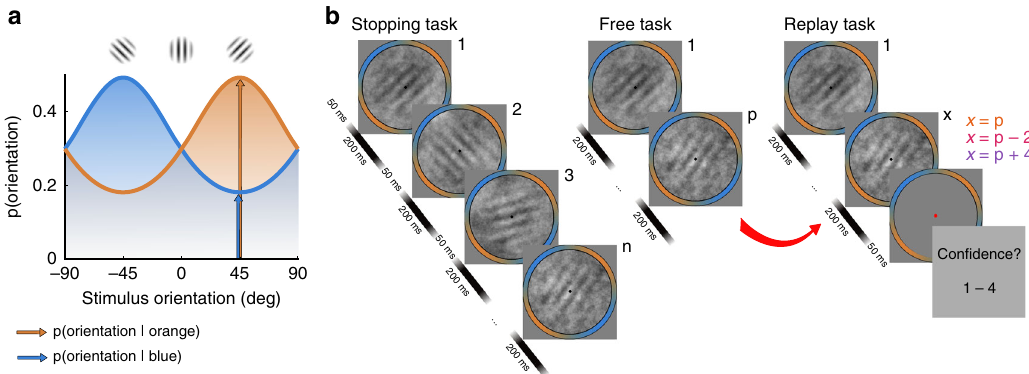
Fig. 1 Procedure. On each trial, observers were shown a series of oriented Gabors and had to determine which distribution the orientations were drawn from. a The orientations were drawn from one of two circular Gaussian (von-Mises) distributions centred on − 45° (blue) and + 45° (orange) relative to vertical (0°). The distributions were overlapping such that a stimulus oriented 45° from vertical is most likely to have been drawn from the orange distribution (orange arrow) but still could have been drawn from the blue distribution (blue arrow). b The experiment involved two sessions. In session 1, observers completed the Stopping task. On each trial of the Stopping task the series of stimuli continued until observers entered a Type-I response: blue or orange distribution. They were asked to enter their response when they felt they had a certain probability of being correct. The three target performance levels (70%, 85% and 90% correct) were completed in separate blocks. In session 2, observers completed the Free task followed by the Replay task. The Free task was the same as the Stopping task, except observers were asked to enter their response when they felt ready (after p samples). In the Replay task, observers entered their Type-I response once cued ( fi xation changing to red). They then gave a Type-II response: a rating (1 to 4) of how con fi dent they were that they were correct. Unbeknownst to observers, the Replay task actually replayed the exact same trials from the Free task, except the number of samples was either the same as they had chosen to respond to ( x = p ), two fewer ( x = p − 2), or four additional samples ( x = p + 4). These trials comprise the Same, Less and More conditions, respectively. Across all tasks, the fi xation point (black dot) and colour guide were present throughout each trial. The samples were presented at a rate of 4 Hz, with 200 ms of stimulus presence (including 25 ms ramp at onset and offset) and 50 ms inter-stimulus interval. All tasks consisted of repetitions of the same 100 trials pre-de fi ned for each